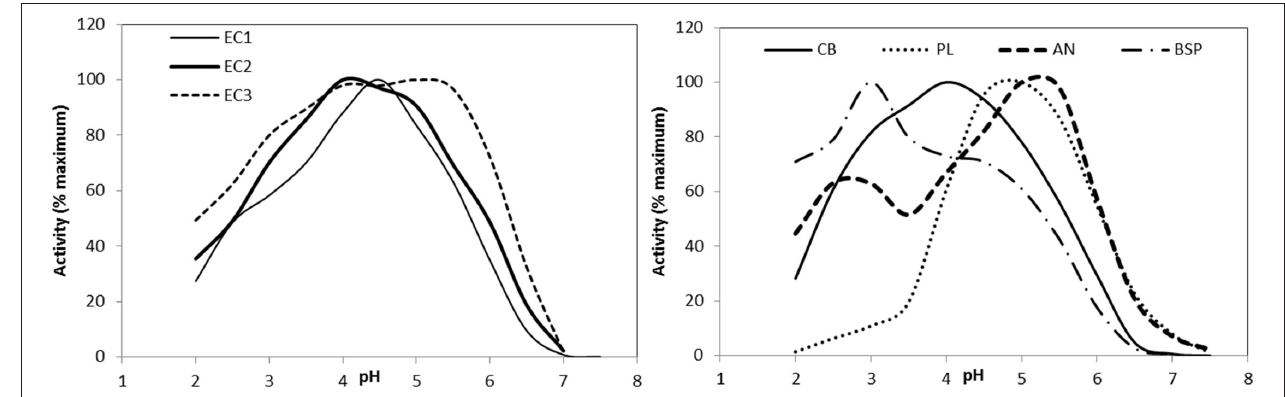
FIGURE 4 | Effect of pH on phytase activity of the phytase products used in the in vitro degradation model with EC1: Quantum (AB Vista), EC2: Quantum Blue (AB Vista), EC3: Phyzyme XP (Danisco), CB: Ronozyme Hiphos (DSM), PL: Ronozyme NP (DSM), AN: Natuphos (BASF), BSP: AxtraPHY (Danisco). Reprinted with permission from (105). Copyright 2015 American Chemical Society.